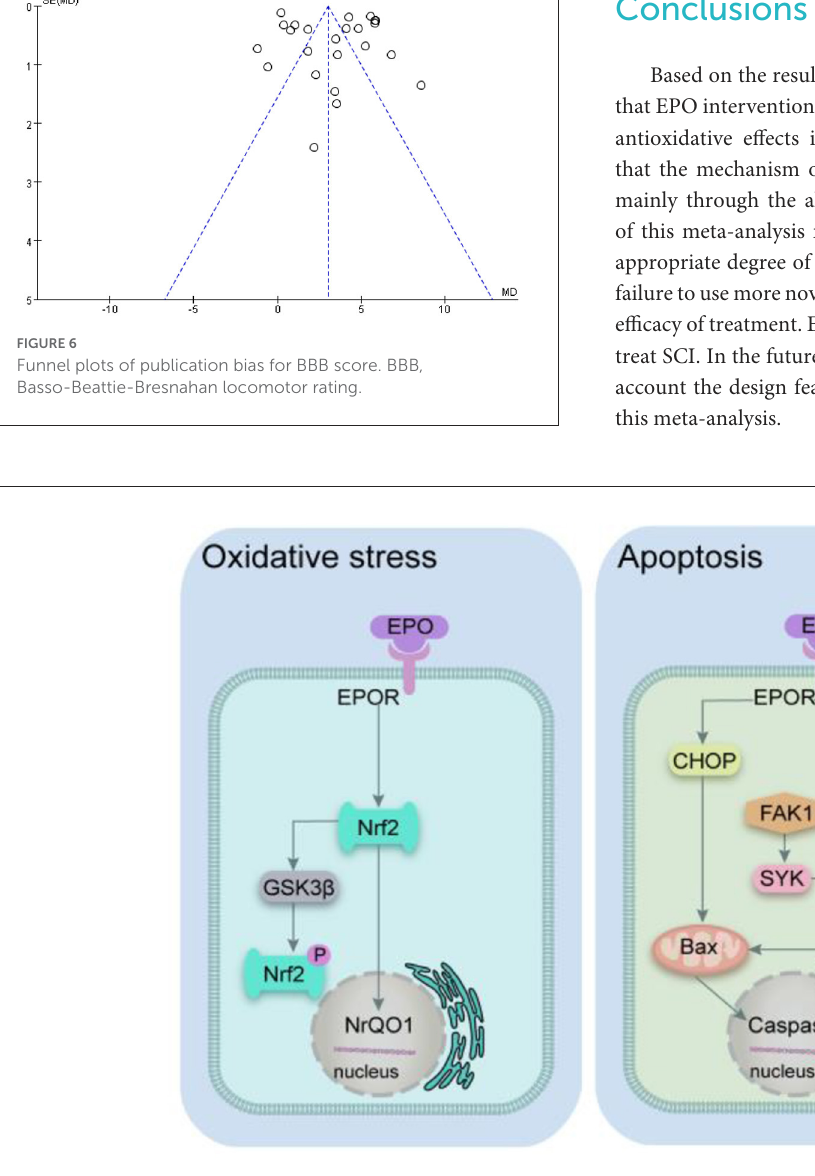
FIGURE7 Mechanism diagram of EPO pathway. EPO, erythropoietin; EPOR, erythropoietin receptor; Nrf2, nuclear factor 2; GSK3 β , glycogen synthase kinase 3 beta; NQO1, (NAD(P)H quinone dehydrogenase 1; CHOP, C/Ebp-homologous protein; BAX, Bcl2-associated x protein; JAK2, janus activated kinase 2; FAK1, focal adhesion kinase 1; SYK, spleen tyrosine kinase; PI3K, phosphatidylinositol 3-kinase; AKT, AKT serine/threonine